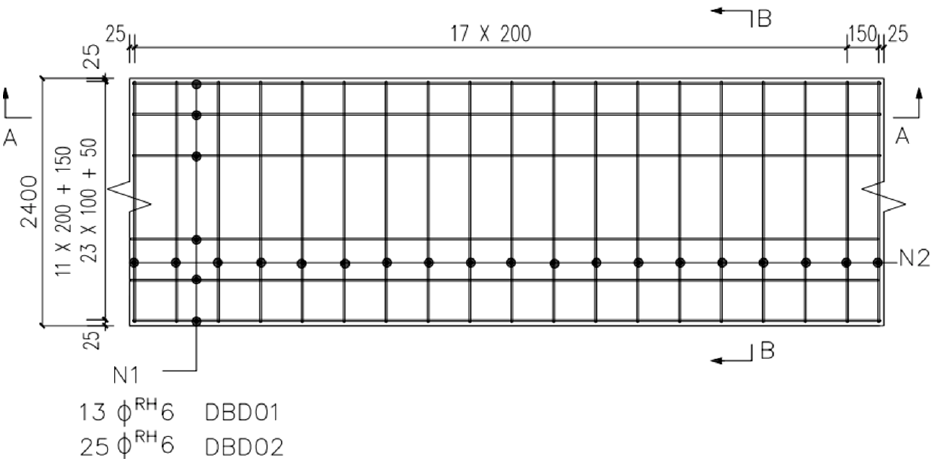
Figure 3. Reinforcement diagram of sandwich laminated floor slab (unit: mm).